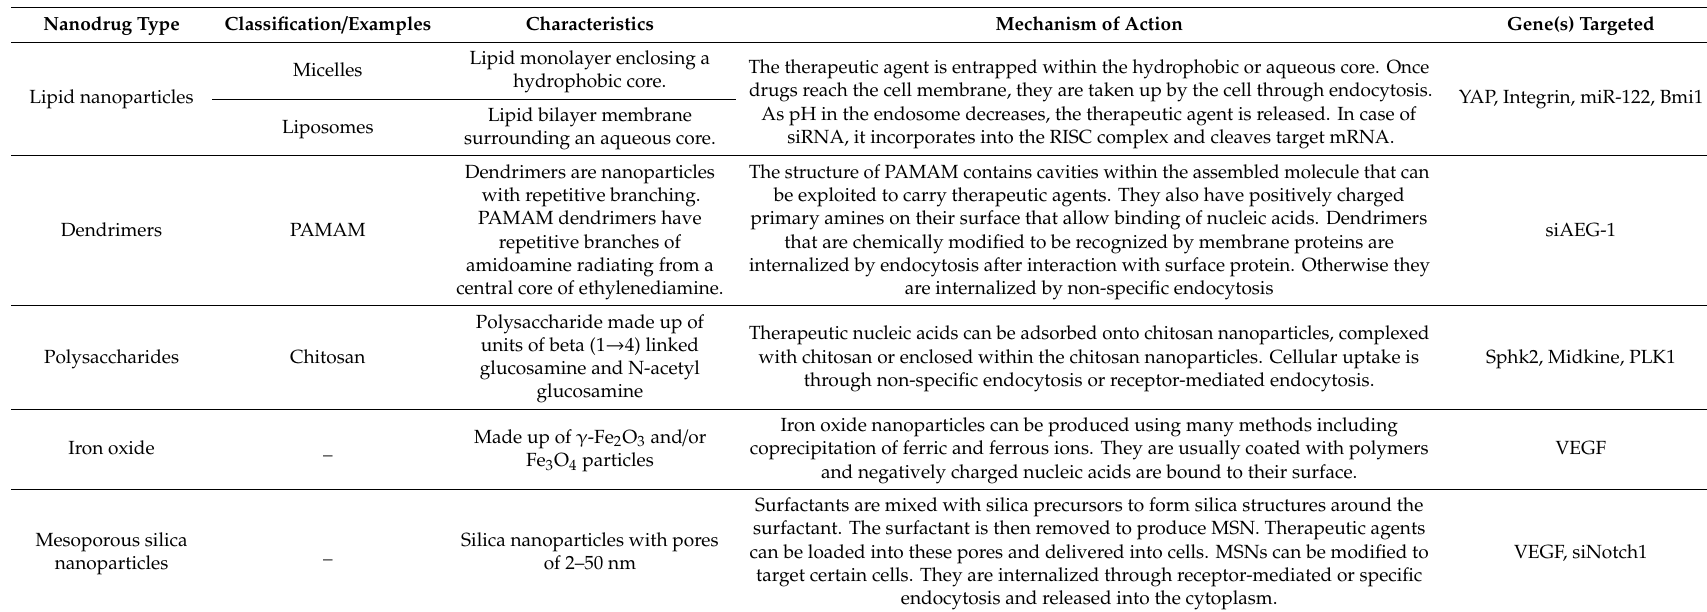
Table 2. The characteristics, mechanism of action and target genes of